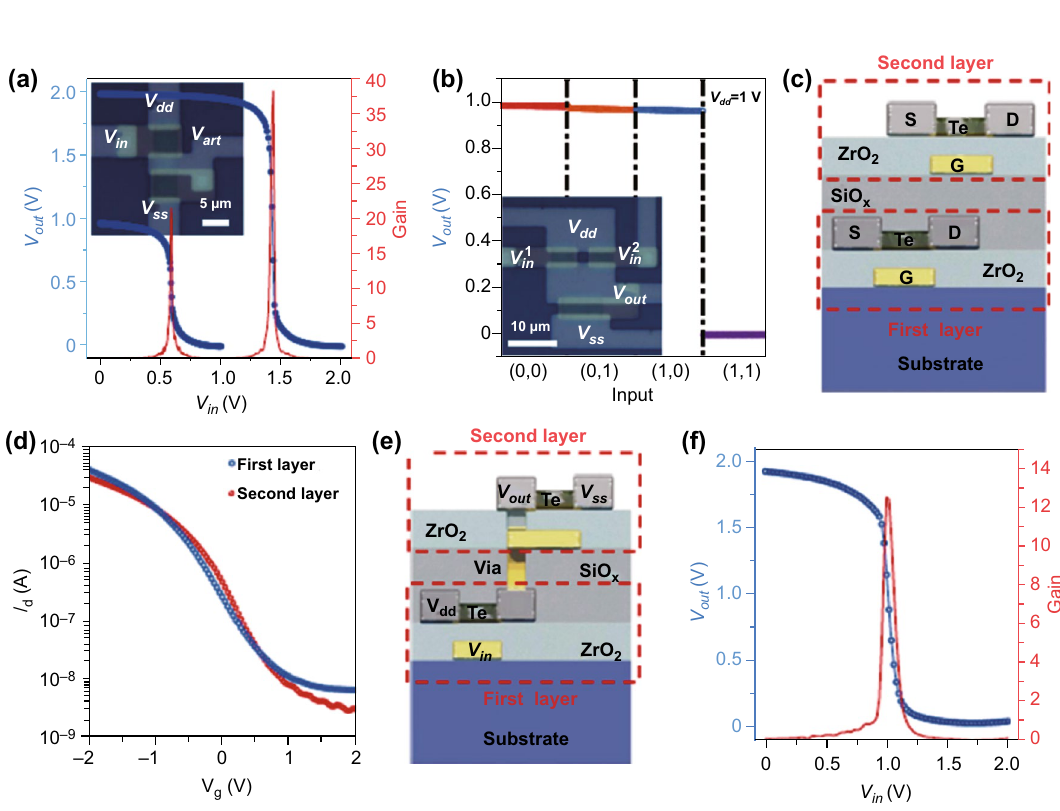
Fig. 17 a , b Inverter, NAND logic gate, and optical images based on p‑type Te FETs. c Schematic diagram of the 3D multilayer transistors and logic gates. d I d – V g transfer curves of the device. e Schematic diagram of the 3D circuits. f Voltage transfer characteristic of the device. Adapted with permission from [178]. Copyright 2020, Nature Publishing